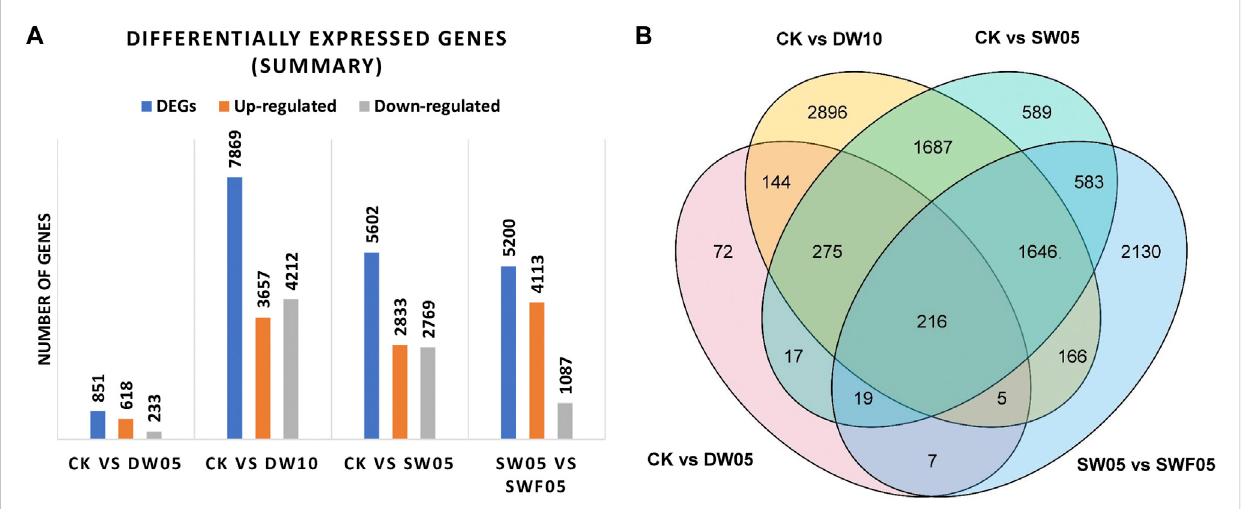
FIGURE 4 Summary of differential gene expression in Adiantum leaves after half-waterlogging, drought stress, and rewatering conditions. (A) Bar chart showing the number of differentially expressed genes and (B) Venn diagram of differential genes in Adiantum leaves. Where, CK = control, DW05 = half- waterlogging for 5 days, DW10 = half-waterlogging for 10 days, SW05 = drought stress for 5 days, and SWF05 = day fi ve after